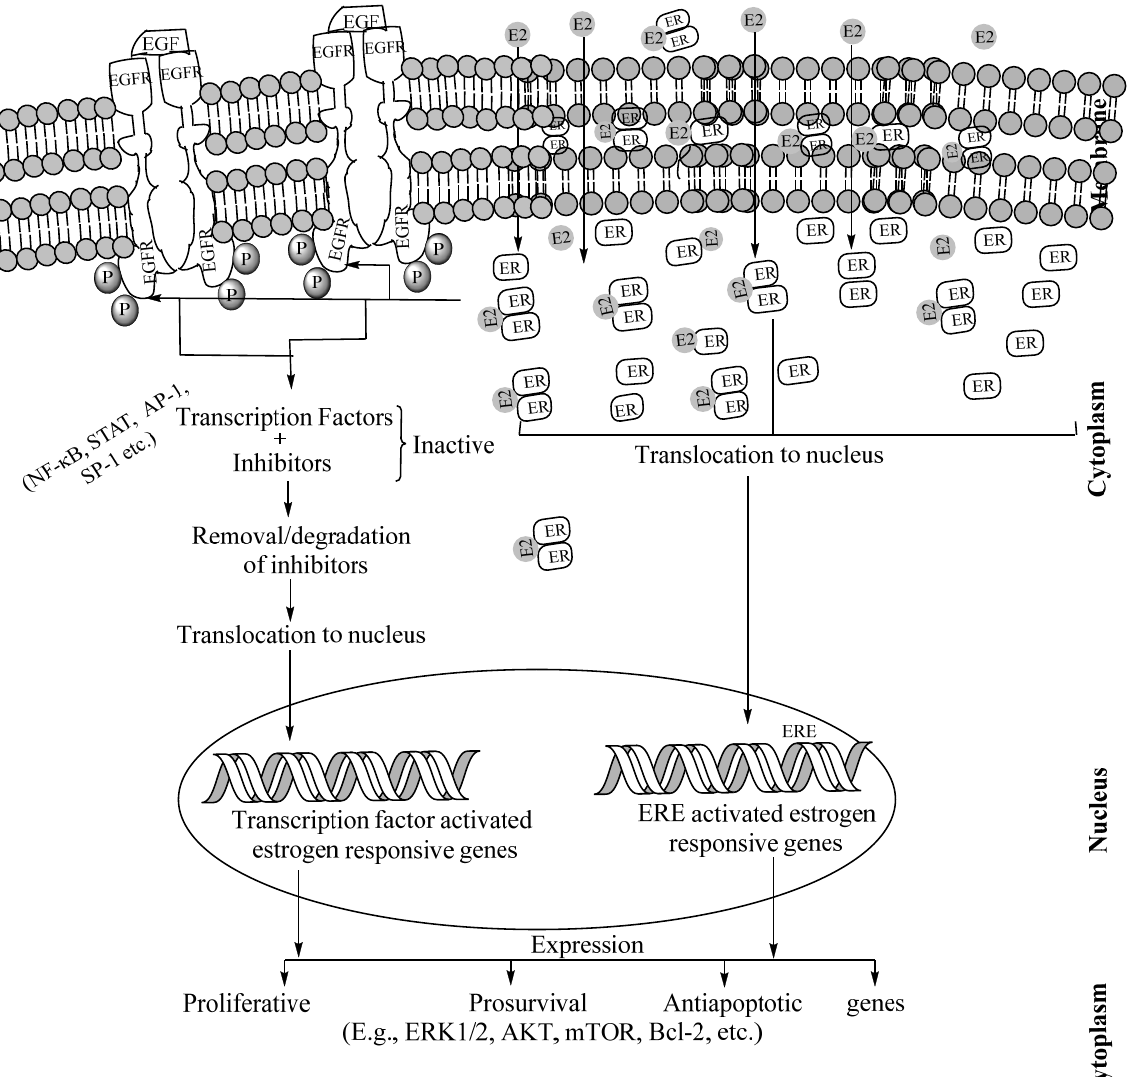
Figure 6. Schematic description of EGFR–ER interactions, initiated by ER dimmers on binding the carboxyl terminal region of EGFR in the cytosol. While EGFRs are transmembrane proteins, ERs are present in the membrane caveolae, cytoplasm including endoplasmic reticulum and mitochondria as well as in the nucleus. The carboxy terminus domain of cytoplasmic EGFR directly communicates with E2-ER dimmers. This cross-talk leads to the activation of estrogen-responsive genes in the following two ways. In the first step, the E2-ER dimer translocates to the nucleus and binds to the estrogen-response elements (EREs) of the estrogen-responsive genes and activates them for transcription. In the subsequent step (in absence of ERE), the estrogen-responsive genes, the EGFR-E2-ER cross-talk activates various transcription factors, translocates them to the nucleus, binds to the specific transcription factor binding sites of the estrogen-responsive genes and activates them for transcription. This transcriptional activation through ERE-dependent or -independent manner leads to the ex- pression of pro - proliferative, prosurvival and antiapoptotic proteins which complicates the tumorigenesis. Of note, E2- ER dimmers and EGF–EGFR interaction have functions independent of their cross-talk. Abbreviations: ER: Estrogen re- ceptor. ERE: Estrogen Response Elements, E2: Estradiol, ECM: Extracellular matrix.